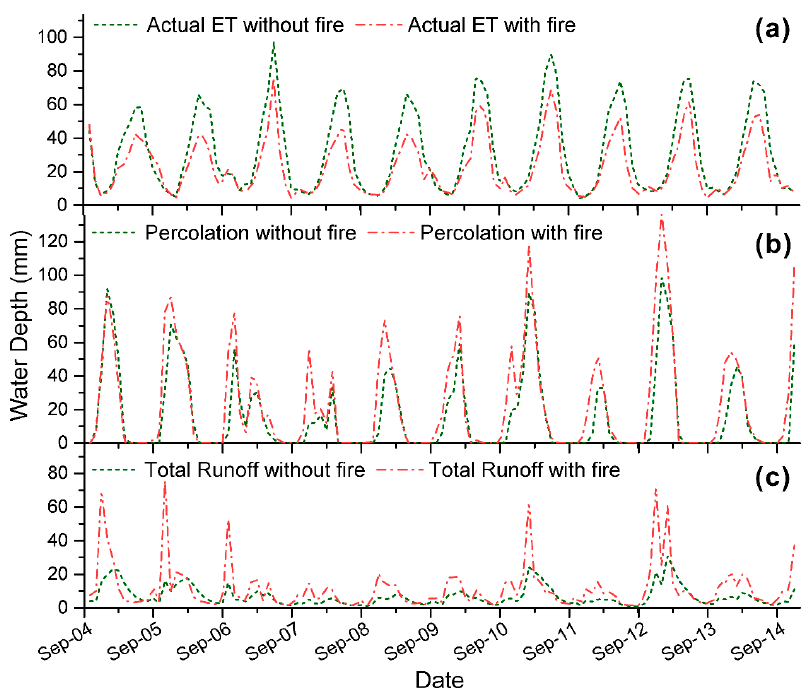
Figure 9. Temporal variation of the main hydrological balance components of the studied watershed for the pre-fire and the post-fire conditions; ( a ) actual evapotranspiration, ( b ) percolation, and ( c ) total runoff.